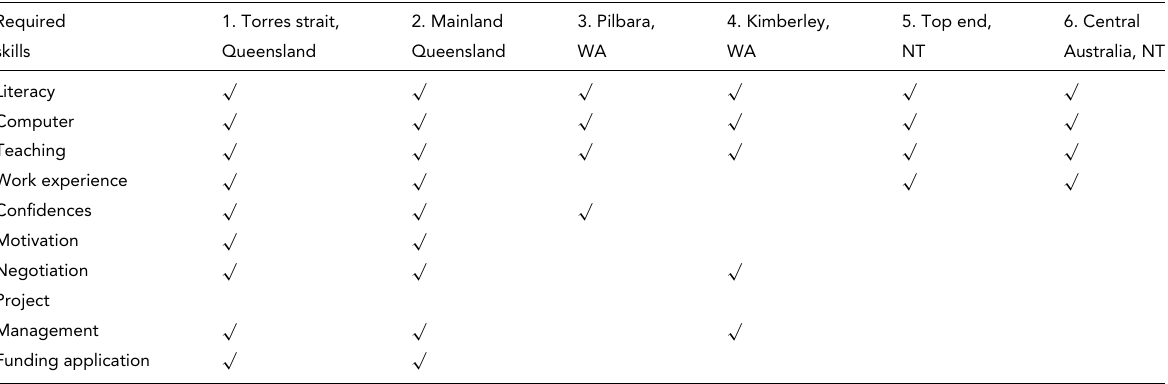
Additional Skills Required by Region, as Recommended by